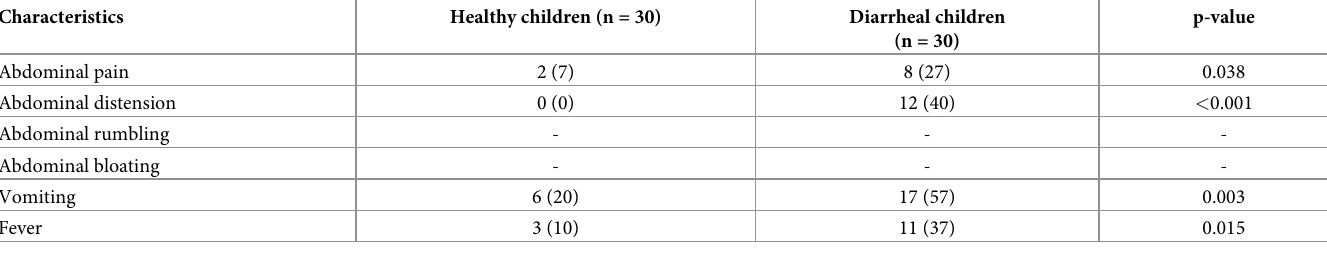
Table 2. Comparison of characteristics between healthy and diarrheal children during pre-intervention period.